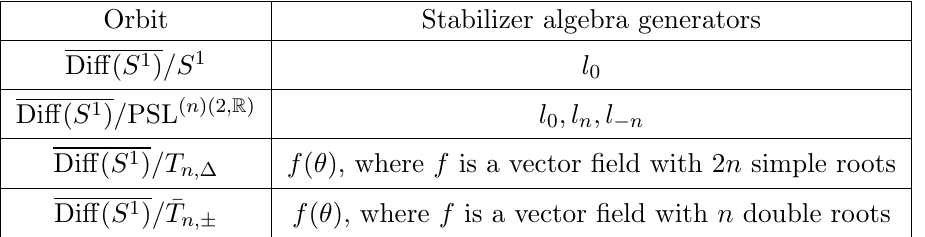
Table 3 . The classi(cid:12)cation of Virasoro coadjoint orbits purely in terms of group manifolds, i.e. without their reference